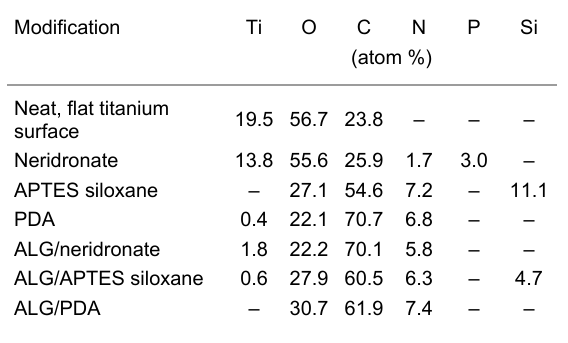
Table 2: Elemental compositions of anchor layers (neridronate, APTES siloxane and PDA) and ALG layers tethered to these surfaces, as determined by